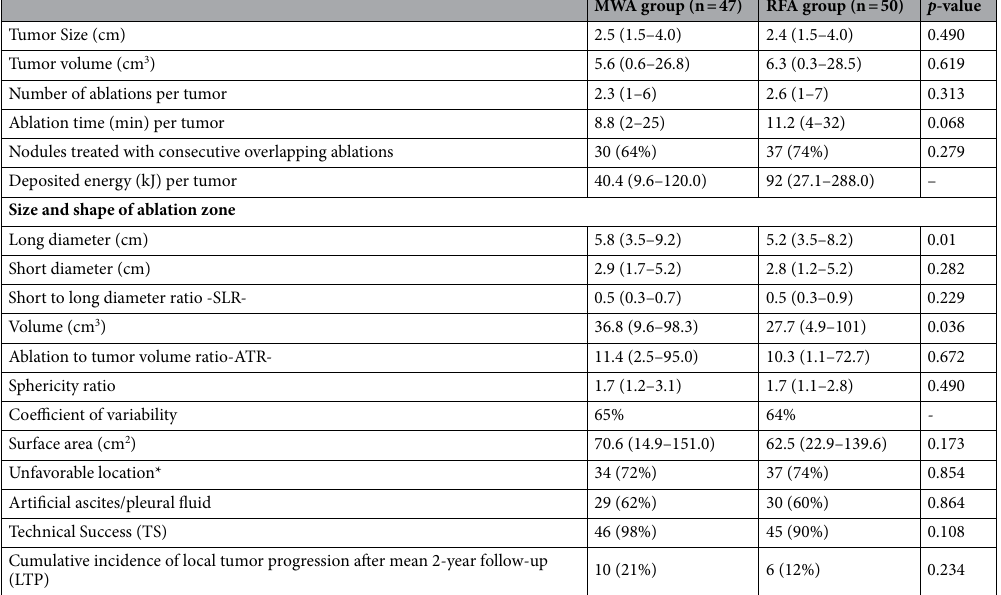
Table 2. Treated tumor information. Data are n (number of tumors), n (%), or the mean (range). All data refer to tumors > 1.5 cm (see inclusion criteria). *See text for definition. Ablations of local recurrences are not included. Analyses are by